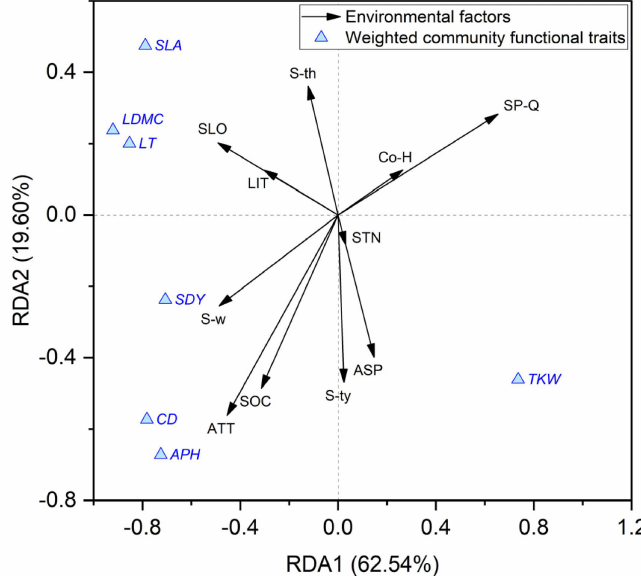
Figure 9. Response of functional traits to compartmental factors. Abbreviations are as follows: ATT: altitude; SLO: slope degree; ASP: slope aspect; S-ty: soil types; S-th: soil thickness; S-w: soil water; SOC: soil organic carbon; STN: soil total nitrogen; SLA, specific leaf area; LDMC, leaf dry matter content; SDY, stem density; LT, leaf thickness; APH, average plant height; CD, crown diameter; TKW, thousand kernel